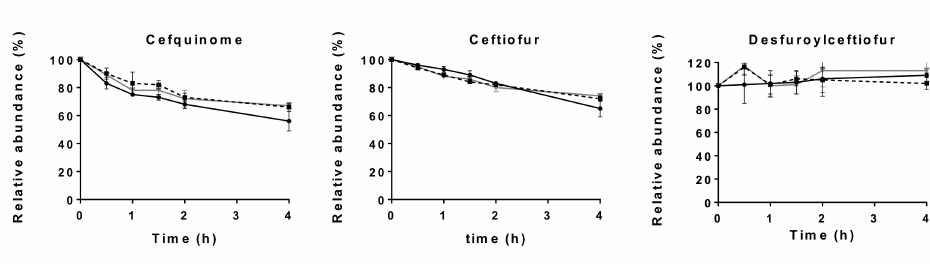
Figure 4. Degradation at room temperature (21 ± 2 ◦ C) over time of cefquinome, ceftiofur and desfuroylceftiofur in a 1000 ng g − 1 spiked fecal sample ( n = 3, per time point) in the presence of a 4 µ g mL − 1 ( • ), 8 µ g mL − 1 (- (cid:4) -) or 16 µ g mL − 1 ( (cid:72) ) solution of tazobactam (mean ± standard